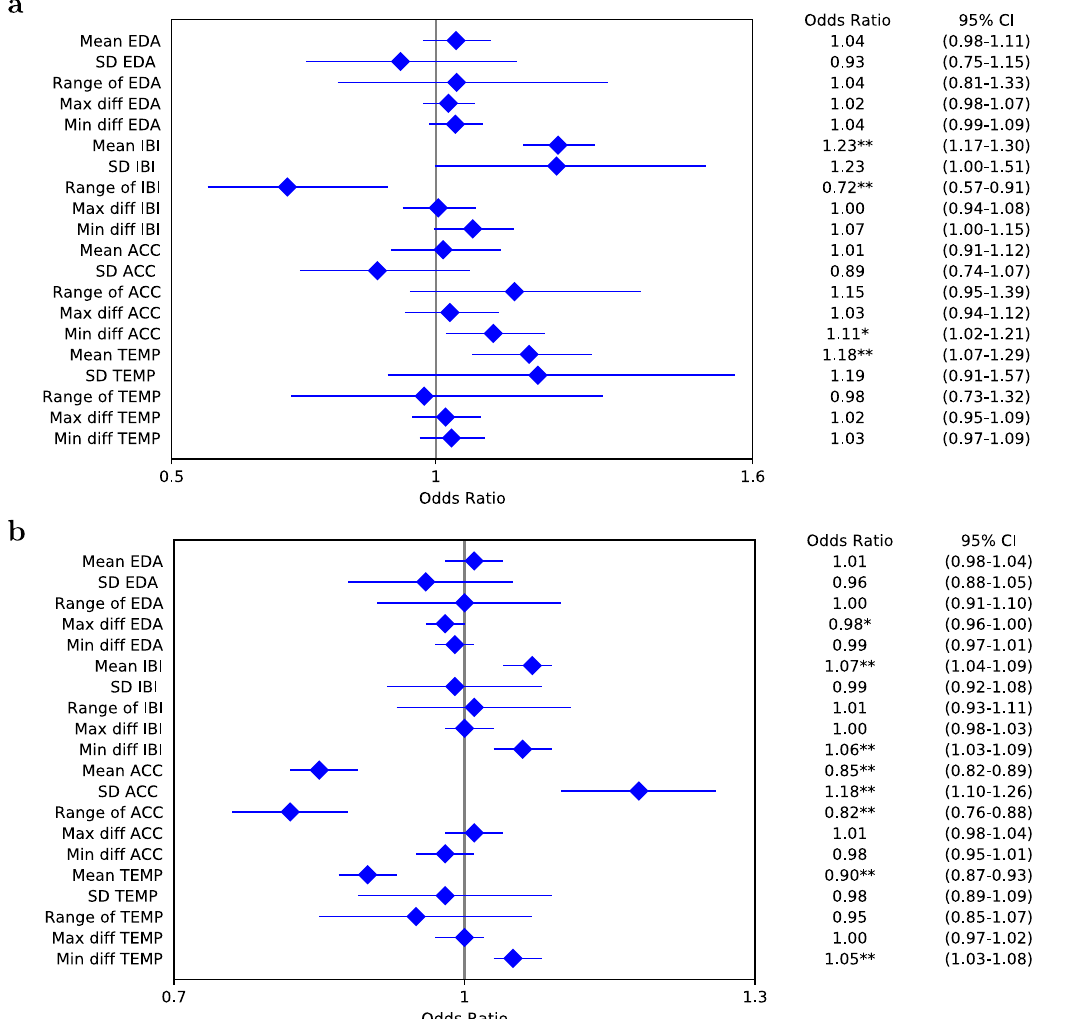
Fig. 2 Forest plots of mixed effects logistic regression showing the association between non-invasive physiological measurements and adverse glycemic events. a Analysis for hypoglycemia. b Analysis for hyperglycemia. The measurements include electrodermal activity (EDA), inter-beat intervals (IBIs), acceleration (ACC), and skin temperature (TEMP). The horizontal error bars represent 95% con fi dence intervals (CIs). The regression coef fi cients were computed for mean values, standard deviation (SD), range, and maximum and minimum differential (diff) values over a one-hour retrospective window. The differential values refer to difference between adjacent measurements. The signi fi cance of a predictor is indicated as * p < 0.05, ** p <